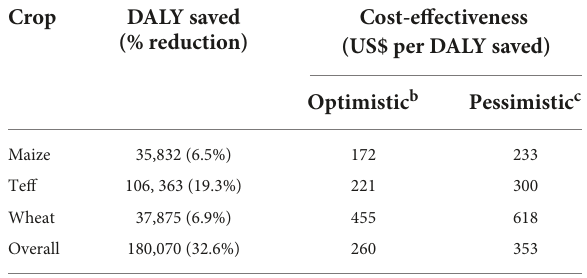
TABLE 3 Potential cost-effectiveness of the use foliar Zn fertilizers combined with pesticides, considering the existing pesticide coverage by crops in Ethiopia a